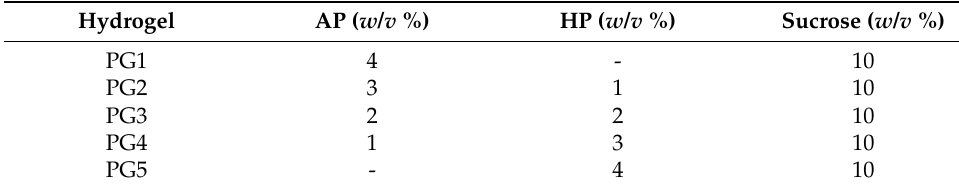
Table 10. Final compositions of the five pectin gel samples.